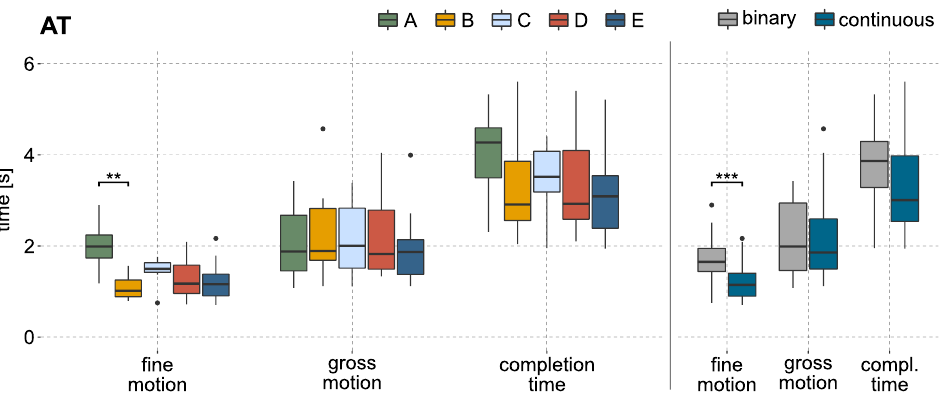
Figure 5. Results of completion time, fine motion, and gross motion time over all subjects during AT, based on the mean values of each subject per labeling method. ( Left ): boxplots of the needed time sorted by labeling method. The statistical analysis identified a significant effect in fine motion time between method A and B. ( Right ): boxplots of needed time sorted by methods based on binary and continuous labels. Binary includes results performed with model A and C; continuous includes results from B, D, and E. The KW test could identify a significant effect for the fine motion time. ‘ • ’ indicates outliers; ‘*’ indicates statistical significance (‘*’ p < 0.05, ‘**’ p < 0.01, ‘***’ p < 0.001).